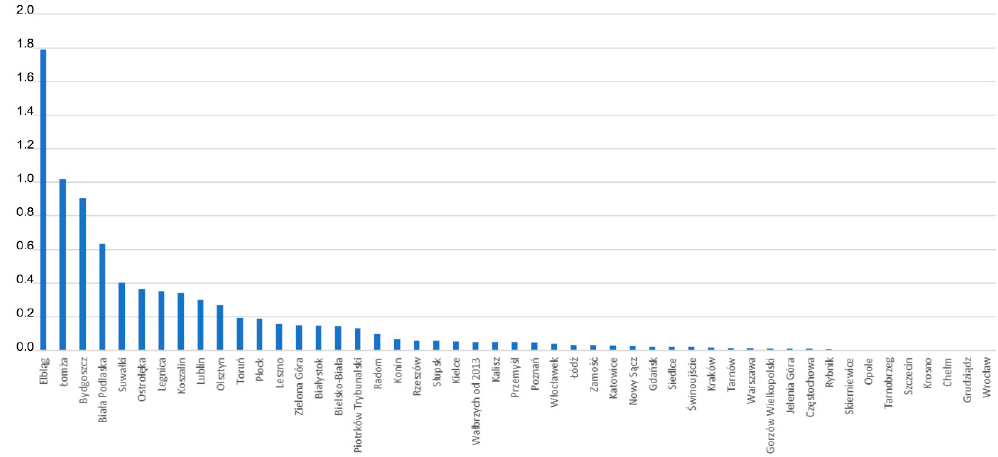
Figure 10. Ranking of cites based on the values of the OU index in 2012–2018.